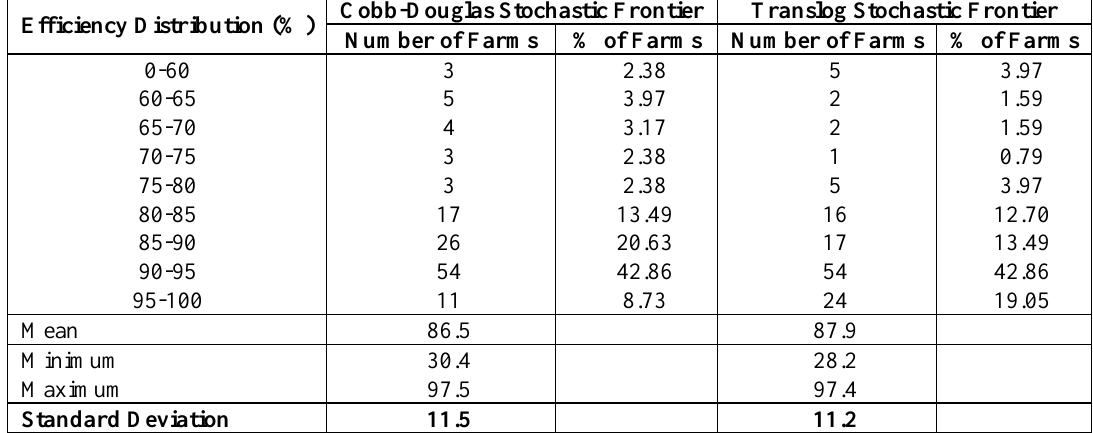
Table 8: Frequency distribution of farm-specific technical